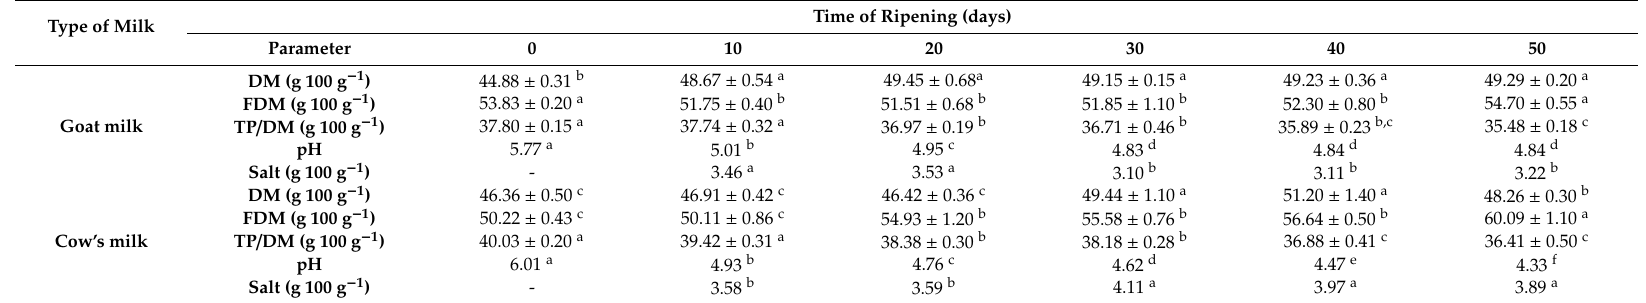
Table 1. The e ff ect of ripening on composition of experimental cheeses